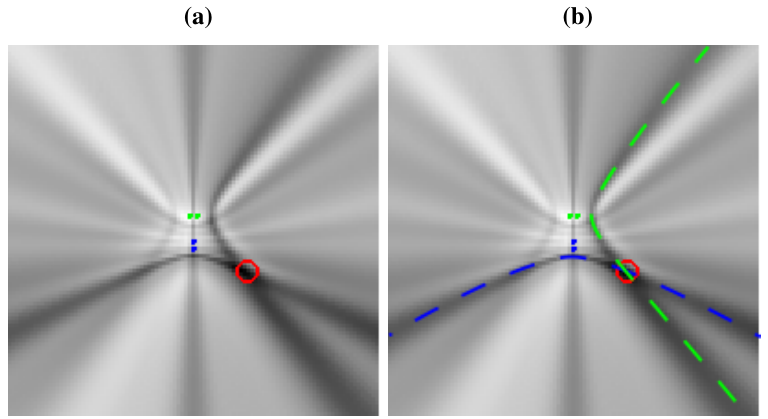
Figure 3. Real SRP-PHAT power map generated for a single speaker located in the red circle with two microphone pairs (blue and green dots). (a) Plain power map; (b) Superimposing ideal hyperbolas that should be generated by the single